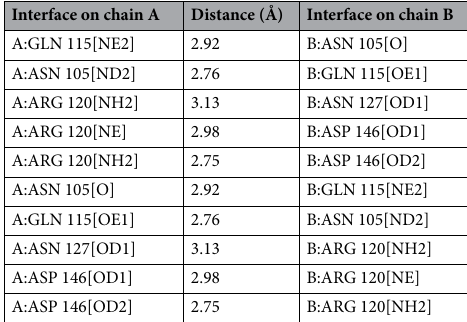
Table 3. Hydrogen bonding at the dimer interface.